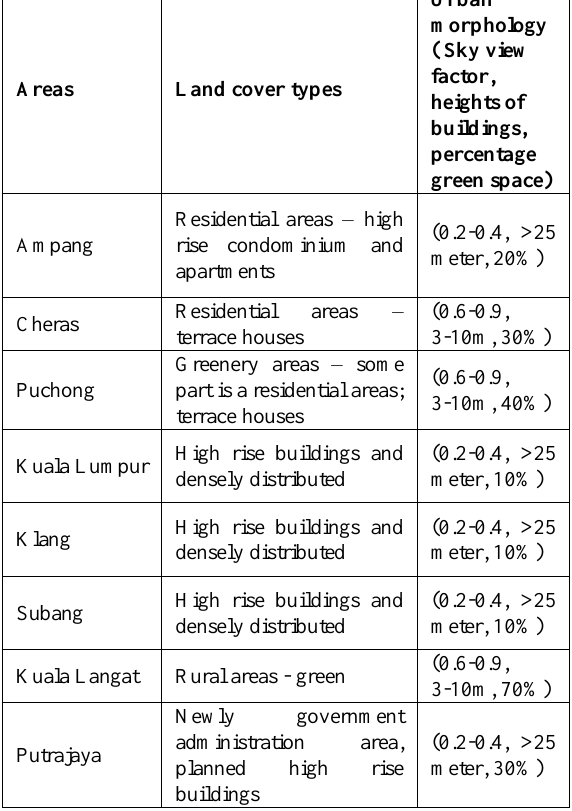
Table 1. Covered areas along with land cover types and